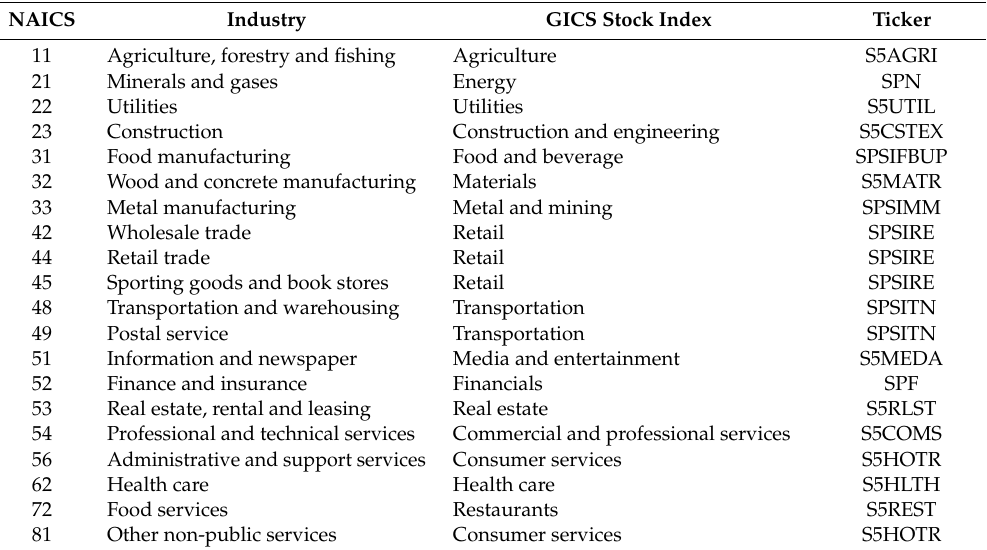
Table 4. NAICS industries and corresponding stock